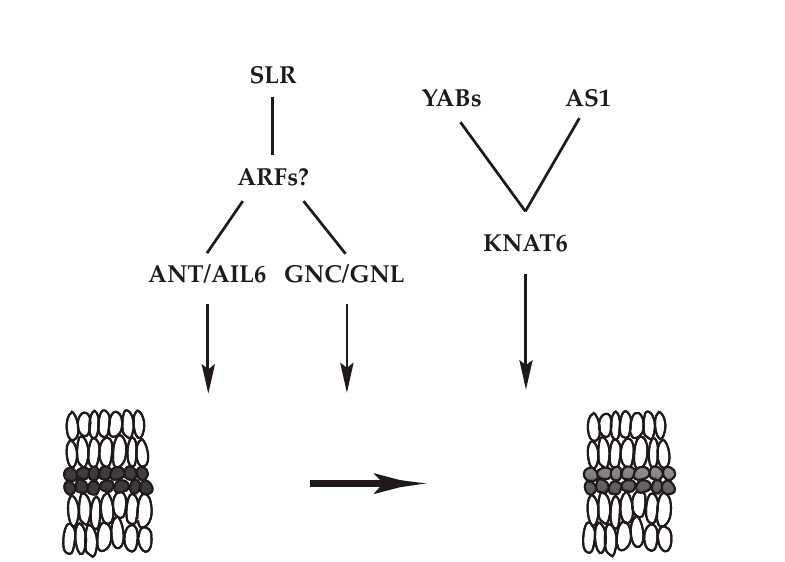
Figure 2. Representatives of the transcriptional modules associated with the formation of separation layer in the AZ of soybean leaf abscission. Transcription factors (TFs) that may define the separation layer in the AZs (Phase 2 possibly through Phase 3) are shown with their cognate regulators. Although Auxin response factors 2 and 7 ( ARF2 / 7 ) were not identified in the transcriptome data of soybean leaf abscission, gene expression of its upstream regulator, SOLITARY ROOT ( SLR ), was up-regulated at the onset of abscission, Phase 2 (Table 1 in Kim et al., 2016). The representative modules constitute ANT / AIL6 and GNC / GNL TFs that are possibly regulated by ARFs and their upstream regulator of SLR, which balance between cell proliferation and differentiation in the AZ at the onset of abscission. In addition, YAB and AS1 TFs may control the expression of KNAT6 gene to regulate Phase 2 of abscission through the establishment of separation layer cells within the AZ.